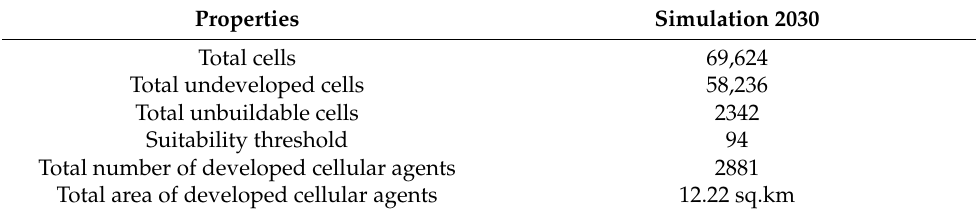
Table 8. Statistical results of simulation map of